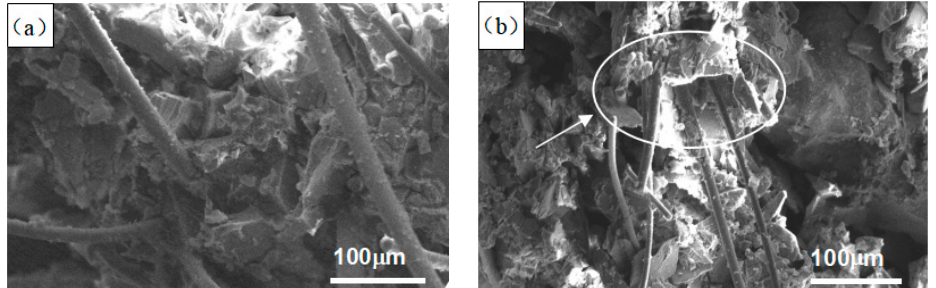
Figure 5. SEM image of green fracture surface of fiber reinforced investment casting shell: ( a ) 0.6 wt.% nylon fiber; ( b ) 0.6 wt.% ceramic fiber.